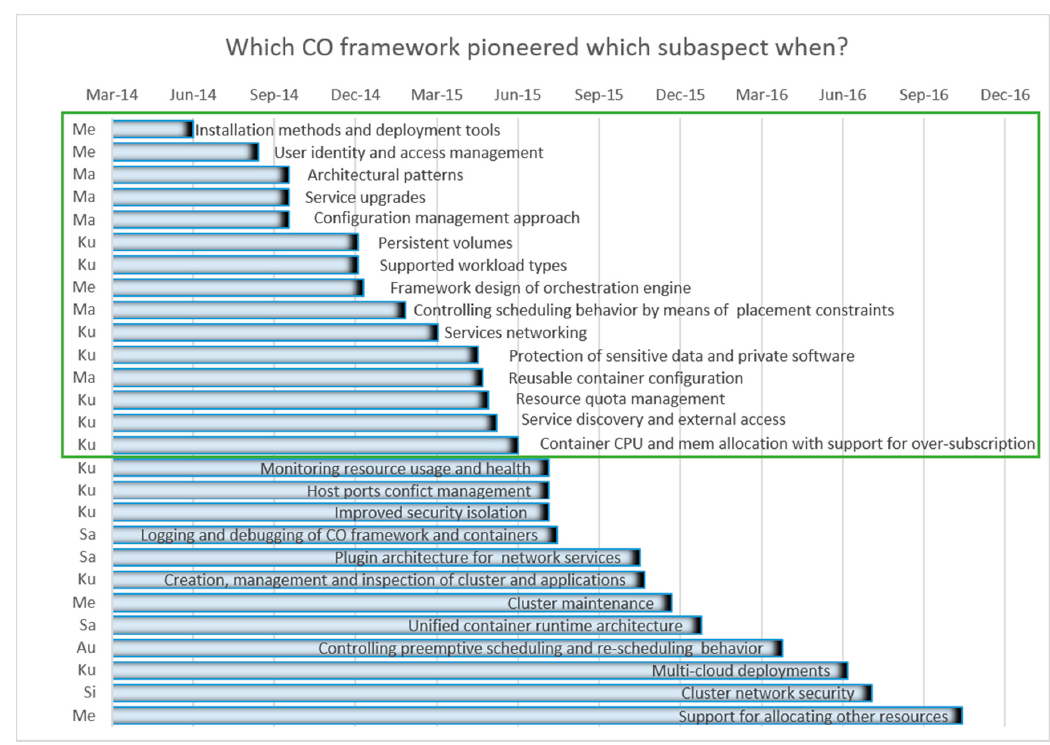
Figure 11. Timeline of when support for a sub-aspect have been consolidated by a CO framework.